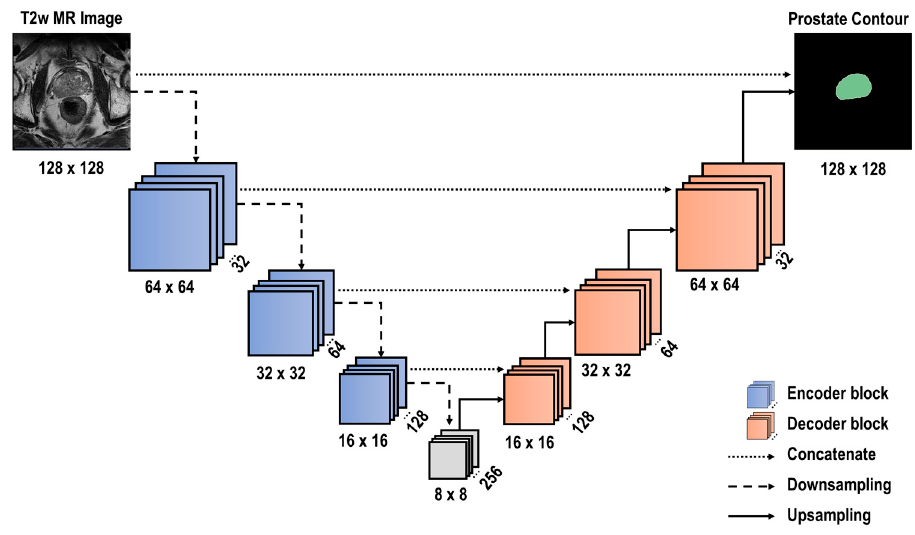
Figure 2. The U-Net architecture used in this study. The encoder contains four convolution layers with pooling. The decoder is symmetrical as the encoder, expanding the in-plane resolution back to the input image. Table 1. The family and individual loss functions used in this study.